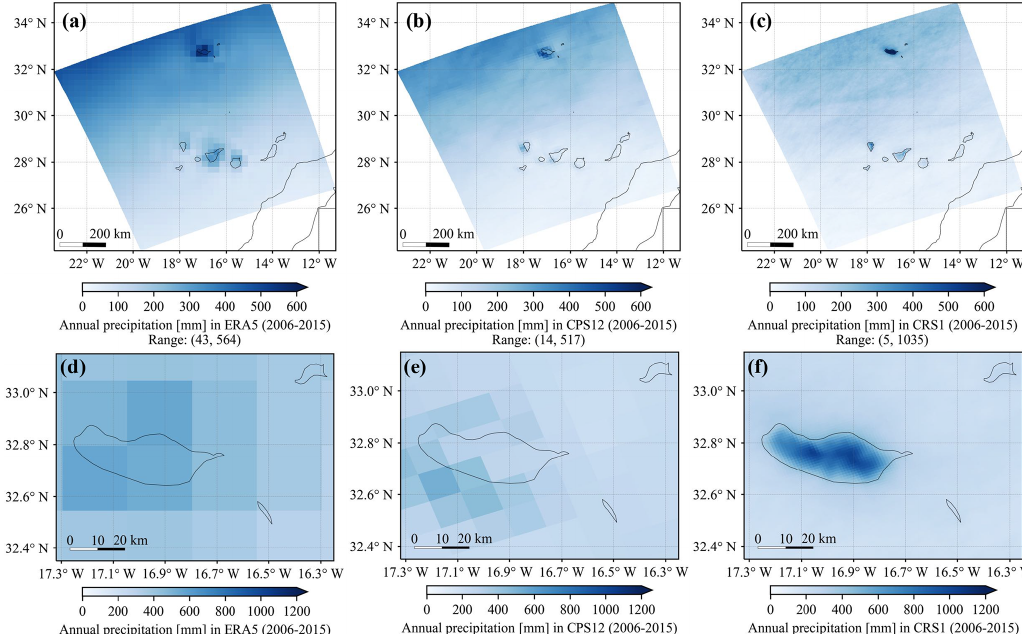
Figure 3. Evaluation of precipitation [mm] against conventional surface stations. Annual-mean precipitation amounts (2006–2015) from (a) the observational dataset, (b) CPS12 and (c) CRS1. Relative biases [%] of (d) CPS12 and (e) CRS1 with respect to observations at stations. The geographic map is from the GADM (Global Administrative Areas) database.